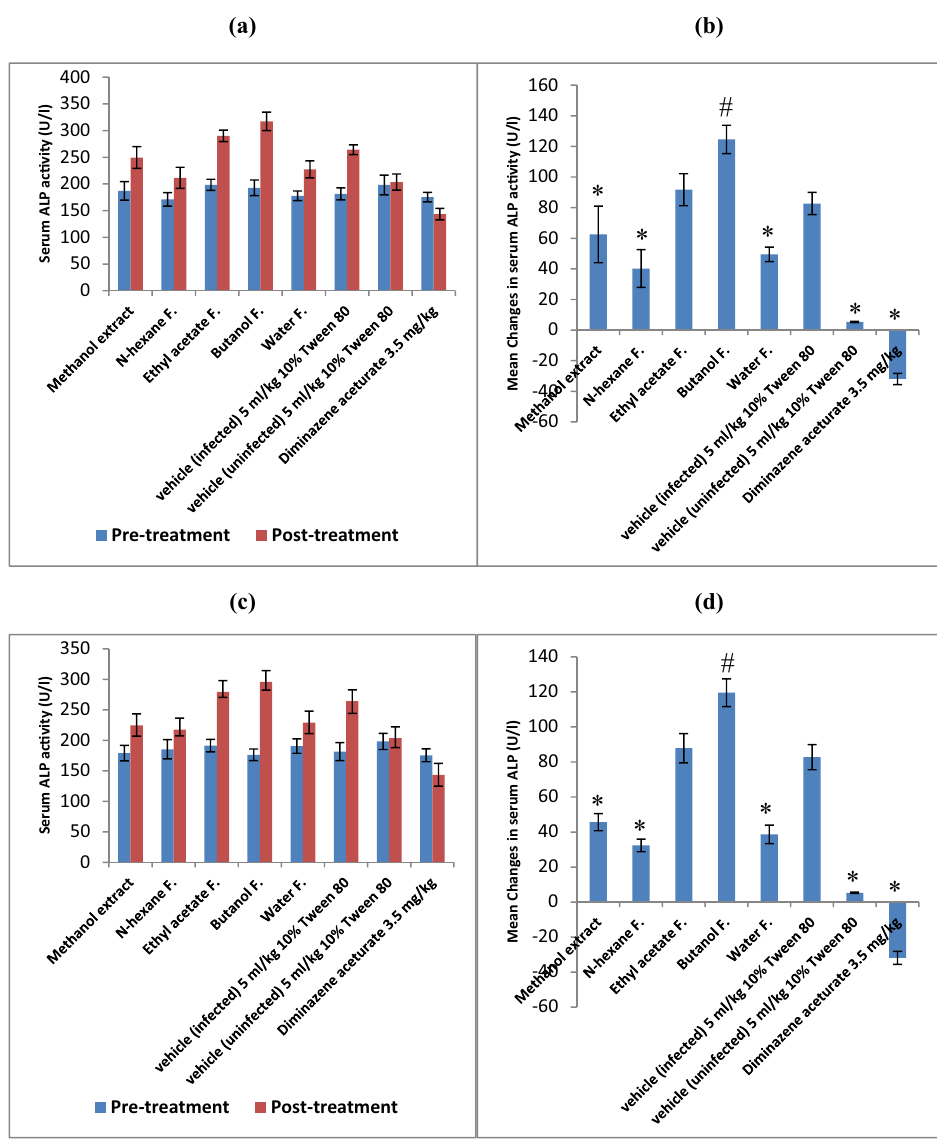
Figure 7: E ff ect of extract and fractions on serum ALP activity of T. brucei brucei - infected animals. ( a ) 200 mg/kg extract and fraction e ff ect on ALP activity; ( b ) 200 mg/kg extract and fraction e ff ect on mean changes in ALP activity; ( c ) 400 mg/kg extract and fraction e ff ect on ALP activity; and ( d ) 400 mg/kg extract and fraction e ff ect on mean changes in ALP activity. * P < 0.05 compared to the vehicle - infected control group ( signi fi cant decrease ) and # P < 0.05 compared to the vehicle - infected control group ( signi fi cant increase )